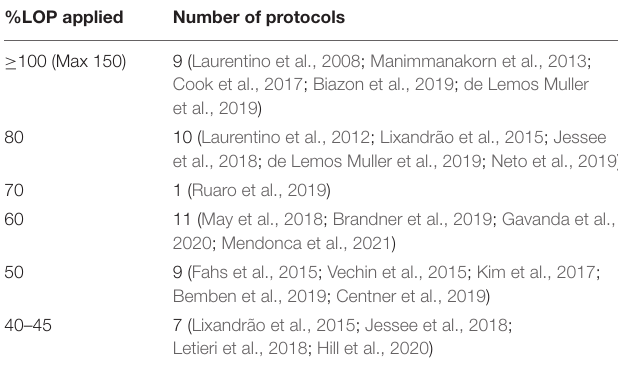
TABLE 1 | Distribution of applied LOP across the 48